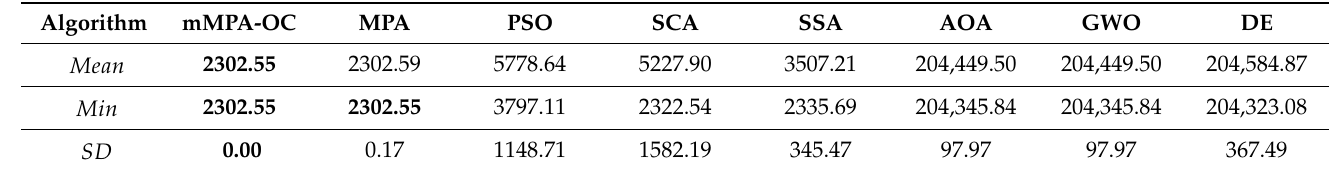
Table 21. Comparison results between mMPA-OC and the other seven meta-heuristics algorithms on the pressure vessel design